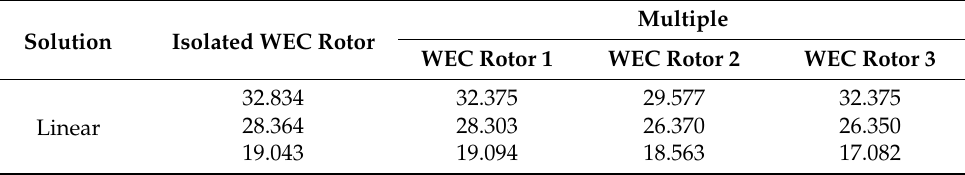
Figure 13. Time averaged optimum extracted power P opt in (kW) from isolated and multiple WEC rotors as a function of the wave-heading angle (°) and wave frequency (rad/s). Comparison of isolated WEC rotor with multiple WEC rotors ( a ) 1, ( b ) 2, and ( c ) 3. Table 4. Peak time-averaged optimum extracted power P opt in kW of isolated and multiple WEC rotors for different wave-heading angles (°).